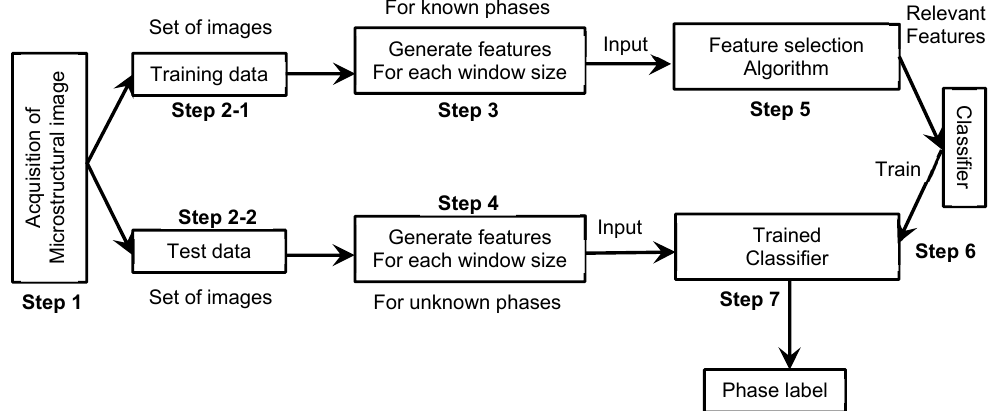
Figure 3. Flowchart of methodology for metallurgical phase identification in ASTM A36 steel using supervised machine learning.